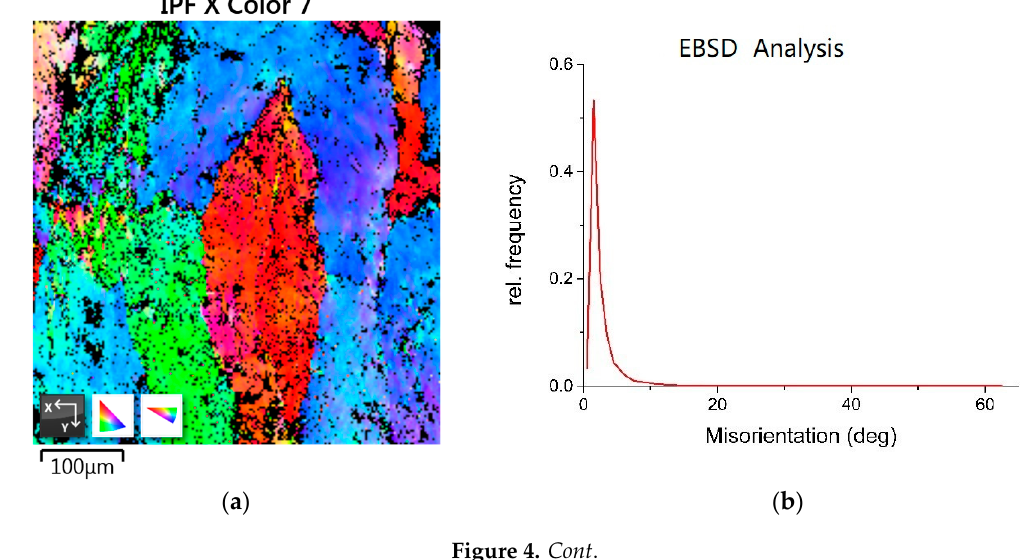
Figure 3. Optical micrographs for an SO sample; ( a ) after forging at low temperature, ( b ) after solution at 475 °C for 45 min, and (c) after solution at 475 °C for 90 min.